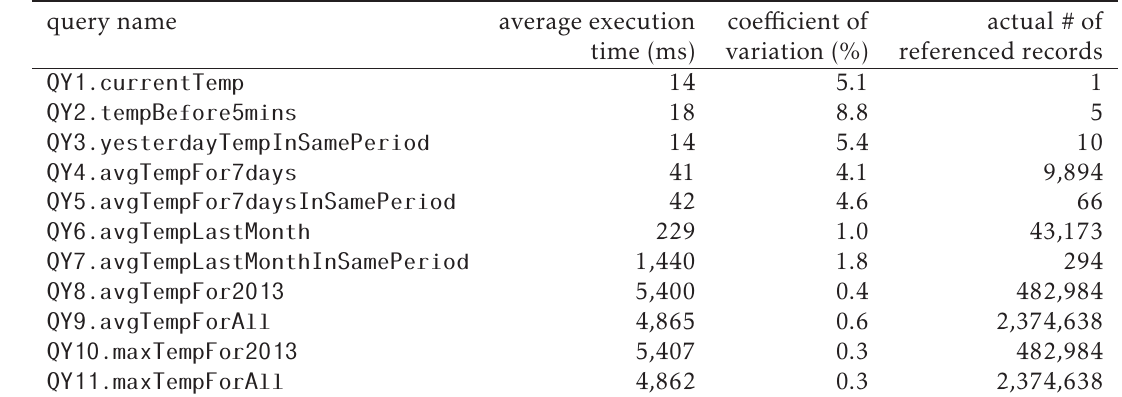
Table 1. Experiment